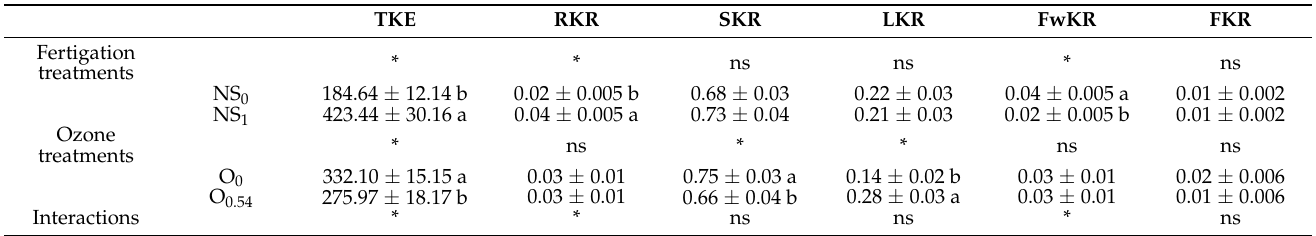
Table 15. Effect of fertigation and ozone on total potassium extracted by plant (TKE) (mg plant − 1 ) and their distribution in root (RKR), stem (SKR), leaf (LKR), flower (FwKR), and fruit (FKR) (dimen- sionless). The data recorded are the means ± standard deviation of four samples per treatment at the end of the experimental period. In each column, different letters or an asterisk (*) denote statistically significant changes between treatments (LSD test; p < 0.05). ns indicates non-statistical differences between